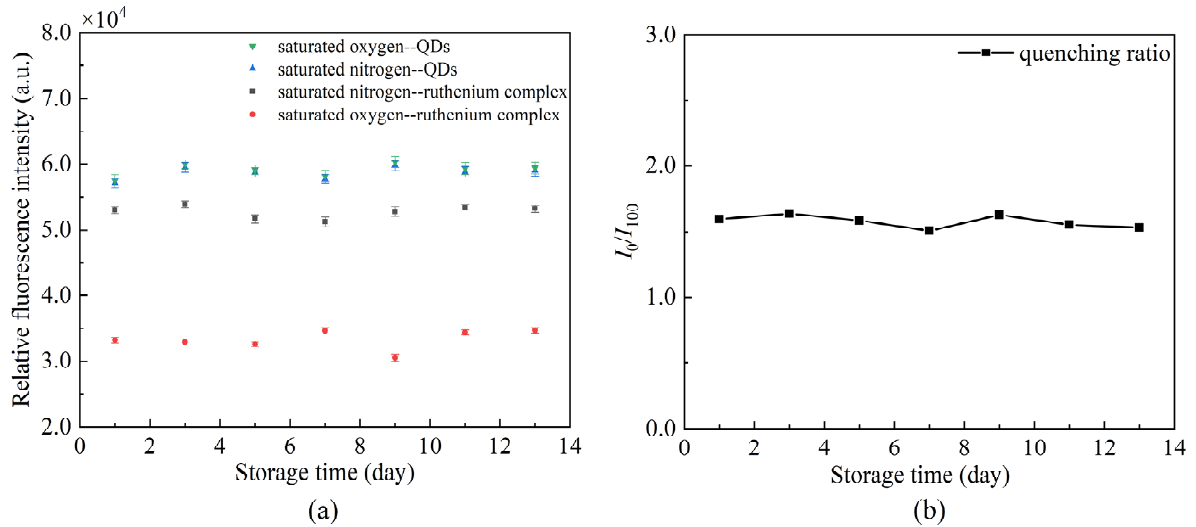
Figure 12. Effects of storage time on the same sensing fiber ( a ) changes of fluorescence intensity, ( b ) changes of quenching ratio